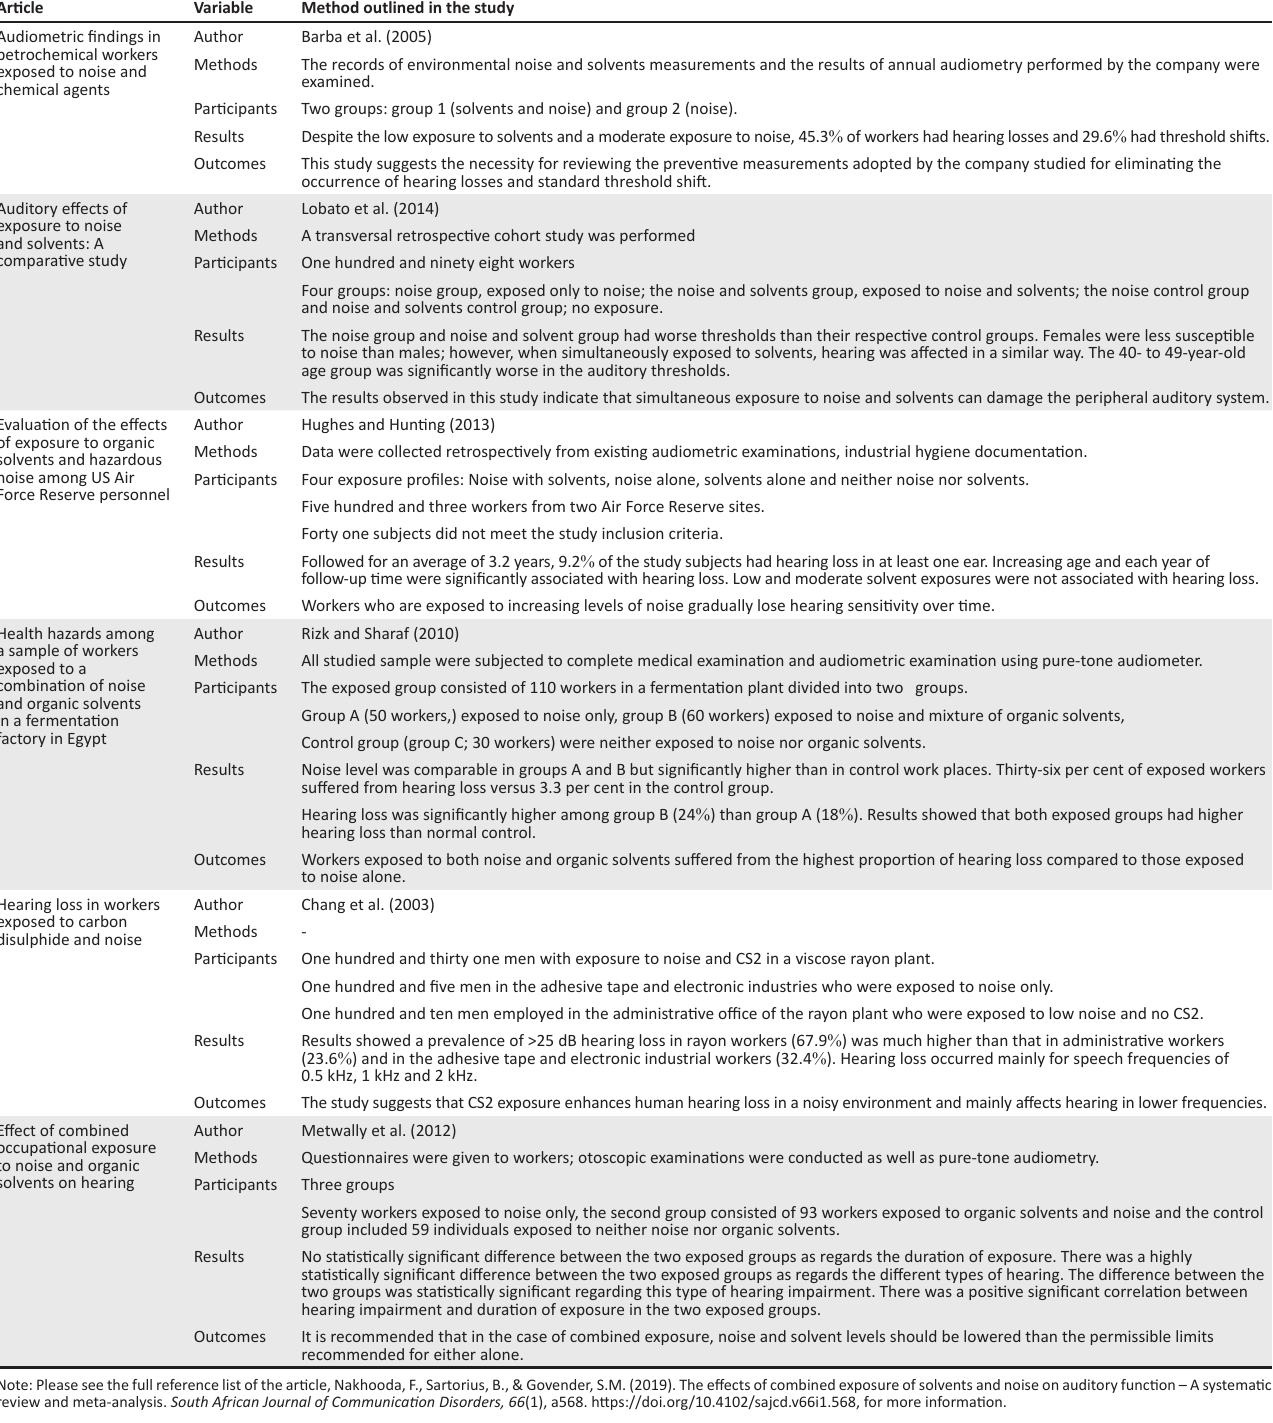
TABLE 1-A1 (Continues...): Characteristics of included